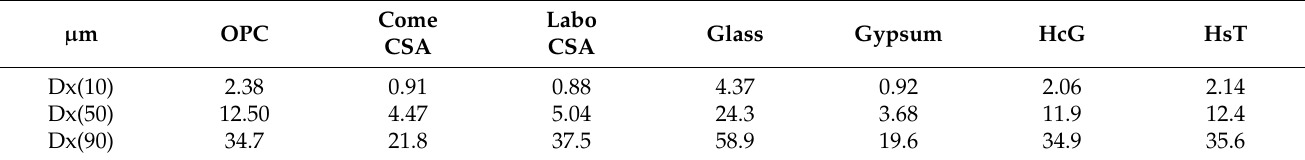
Table 3. D10, D50, and D90 values identified by laser granulometry.